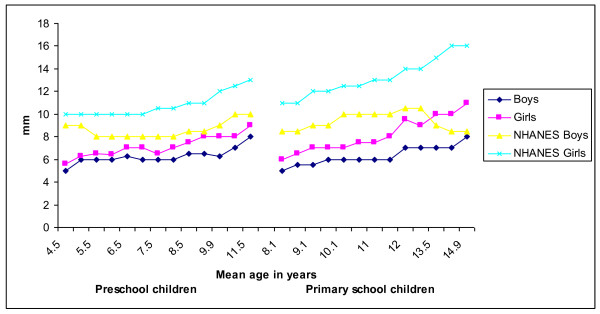
Development of median triceps skinfold of Ellisras rural children and NHANES III (Frisancho, 1990) reference population.